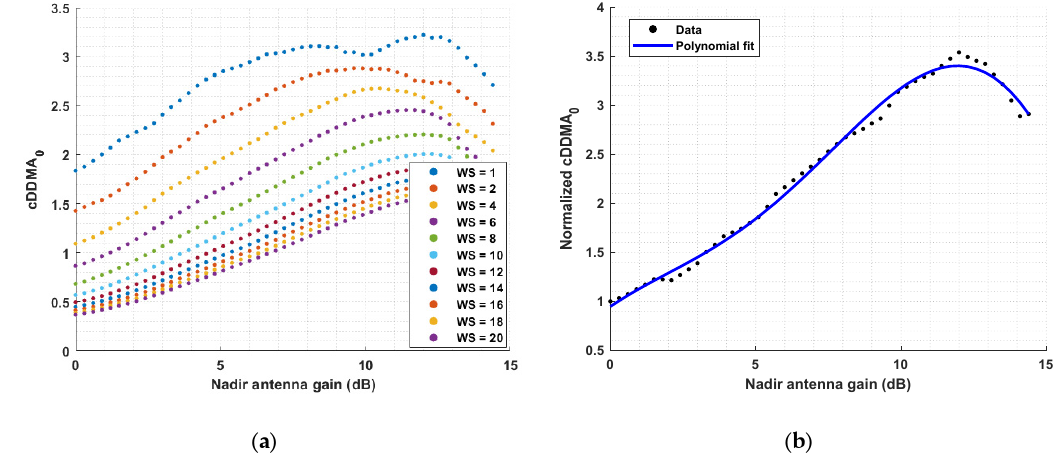
Figure 7. ( a ) cDDMA 0 versus nadir antenna gain at the specular point. The different colors indicate different wind speeds. ( b ) Normalized cDDMA 0 obtained from ( a ) for all gain values and wind speeds versus the nadir antenna gain, represented by the black dots. The blue curve is a fourth-order polynomial function that fits the data.